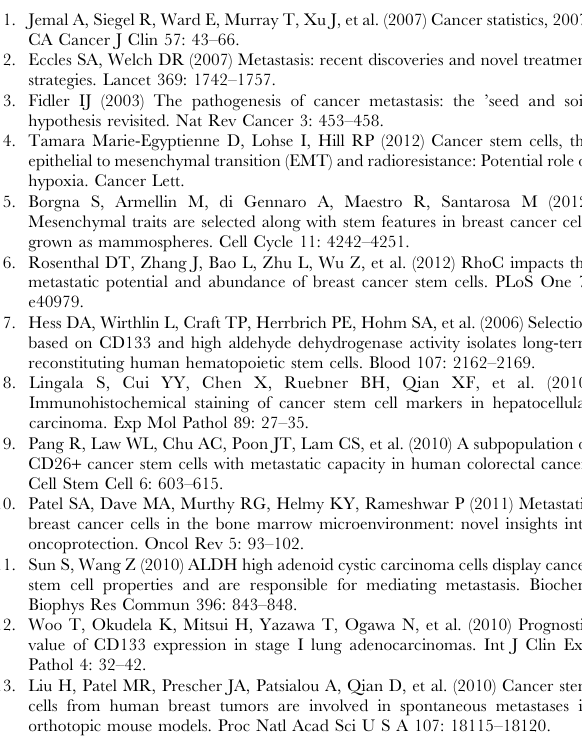
Table S1 The number of zebrafish embryos used in different injection